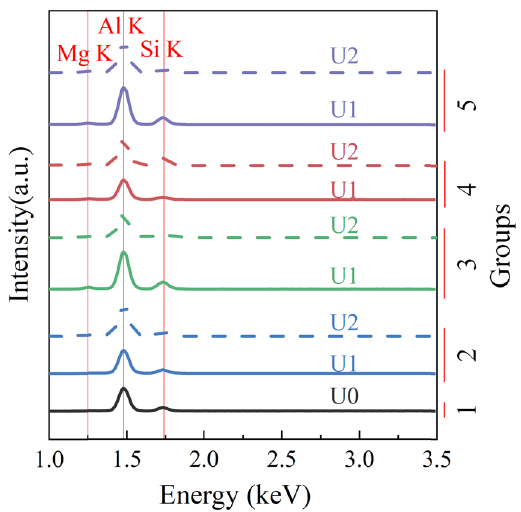
Figure 3: EDS analysis for